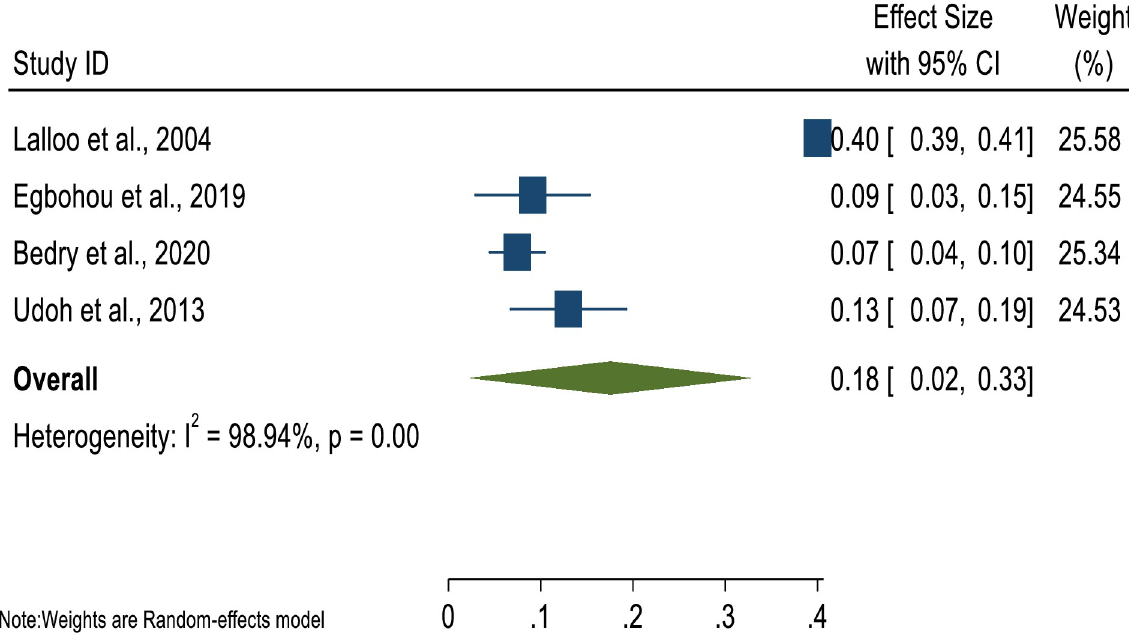
Fig 4. Forest plot of pooled incidence proportion of children in Sub-Saharan Africa.